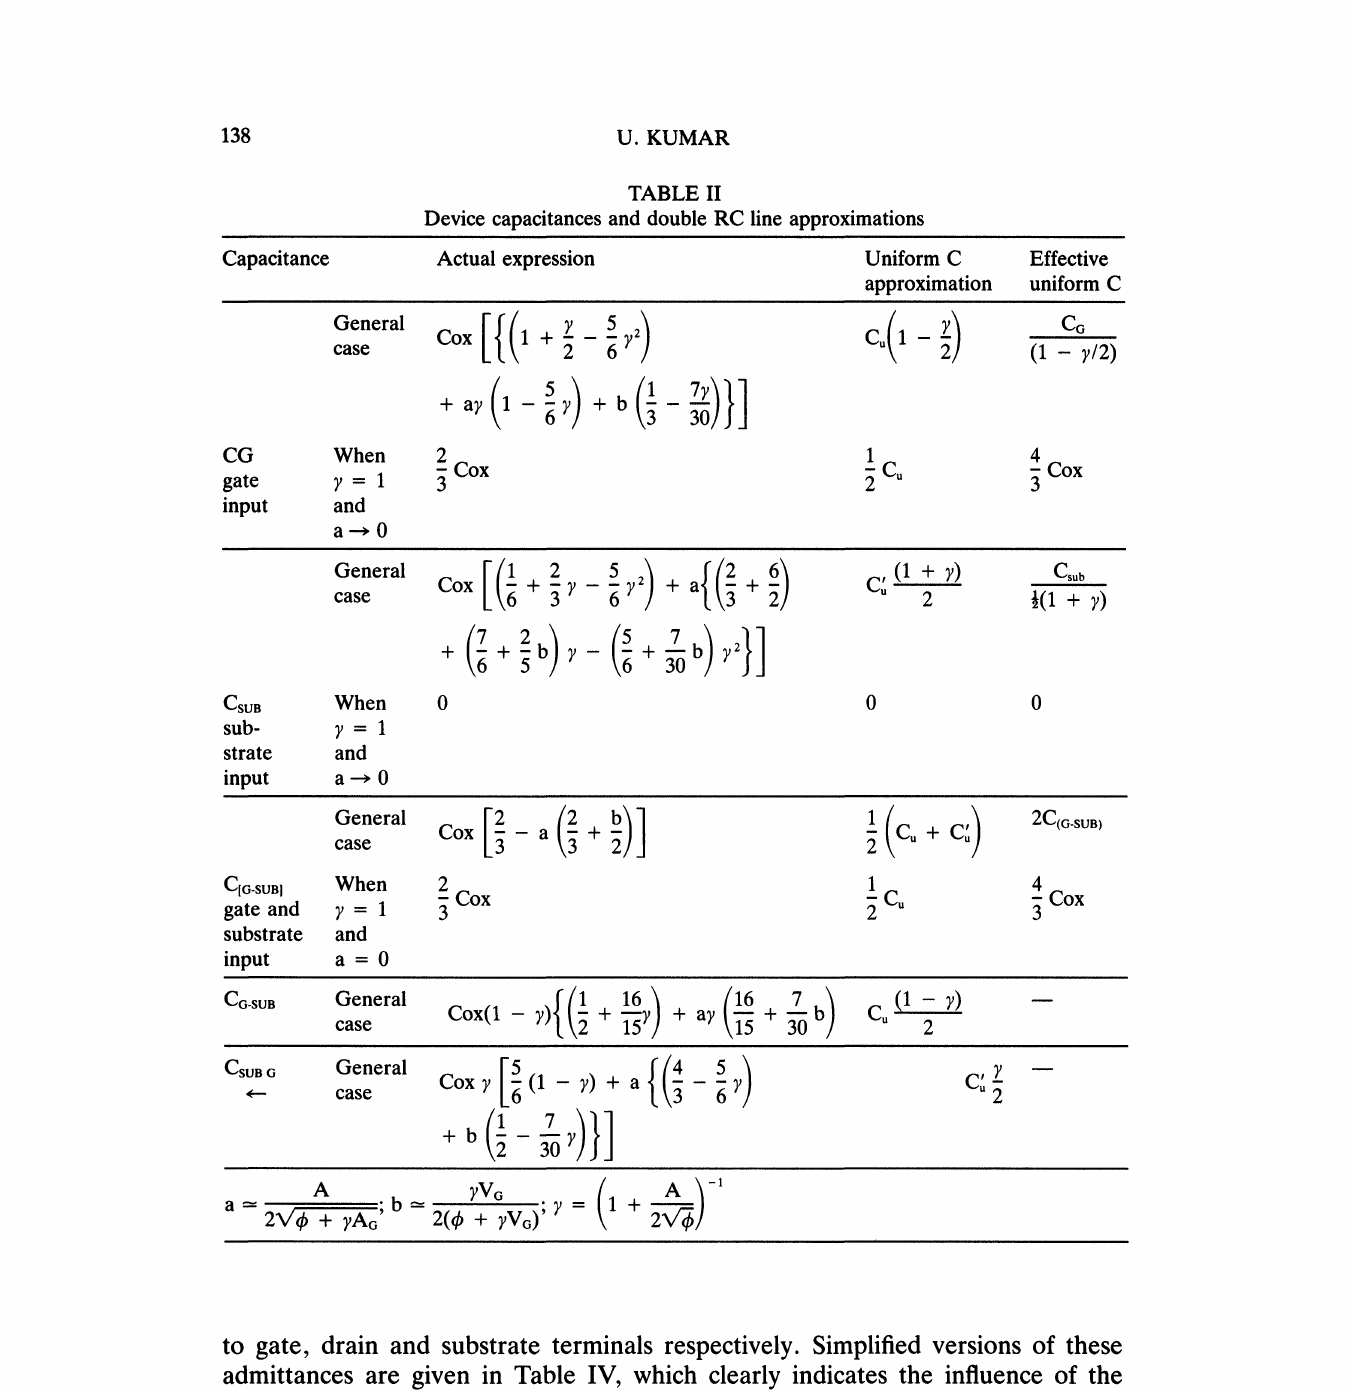
Device capacitances and double RC line